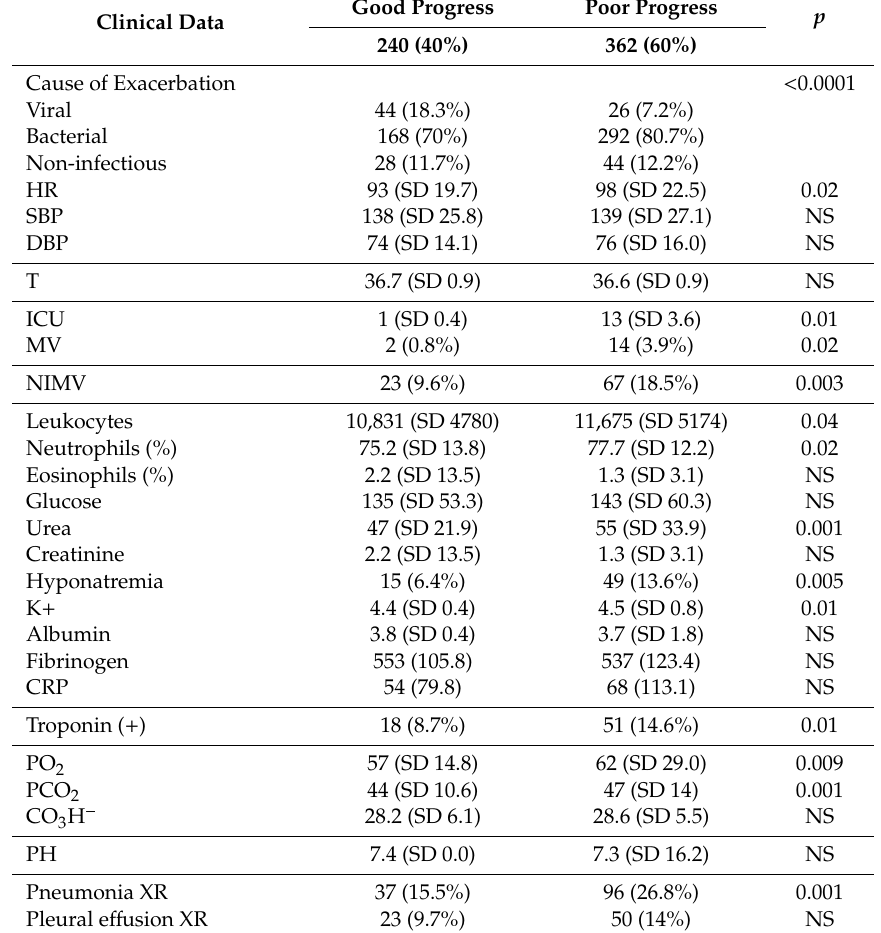
Table 3. Exacerbation